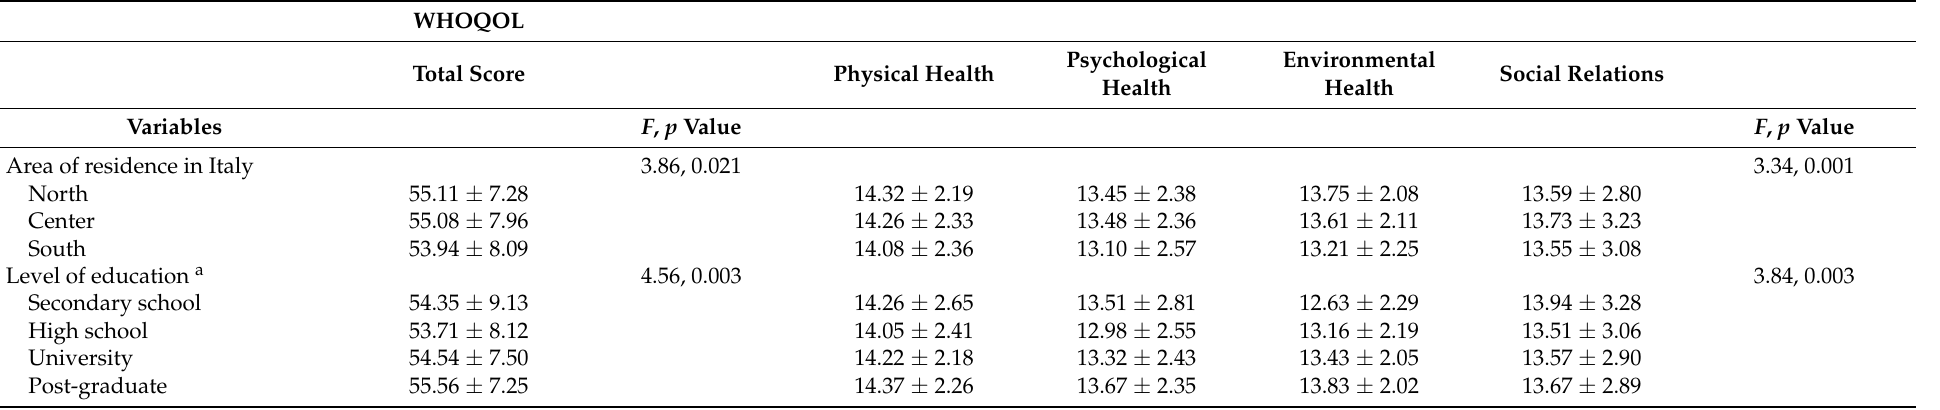
Table 4. Means ± standard deviations and statistics of ANOVA and MANOVA analyses pertaining respondents’ quality of life during the outbreak of COVID-19 ( n =